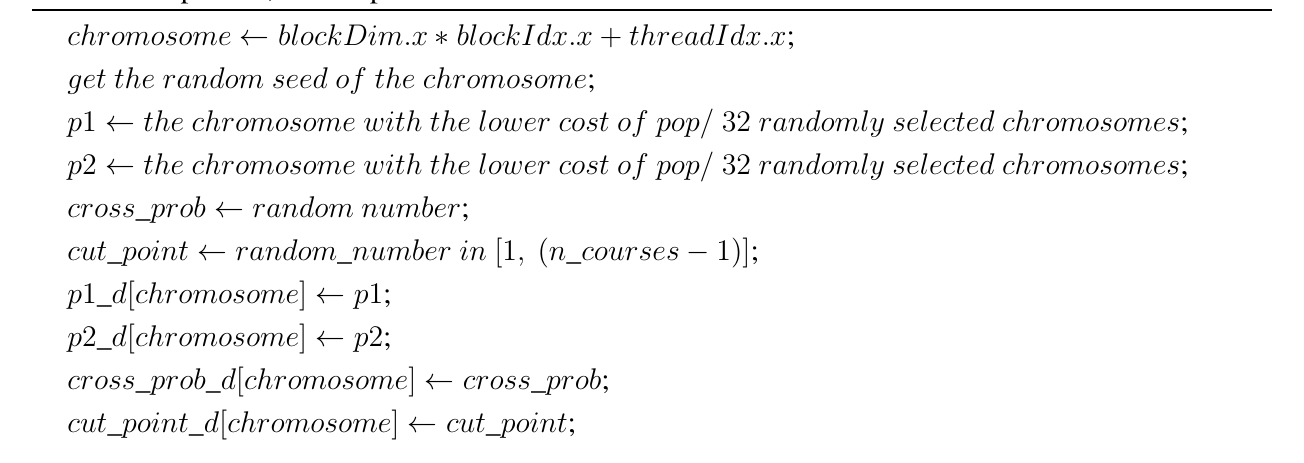
Algorithm 6: Selection, examination-threaded approach (two kernels implementation): each thread selects the parents, the cut point and creates a random